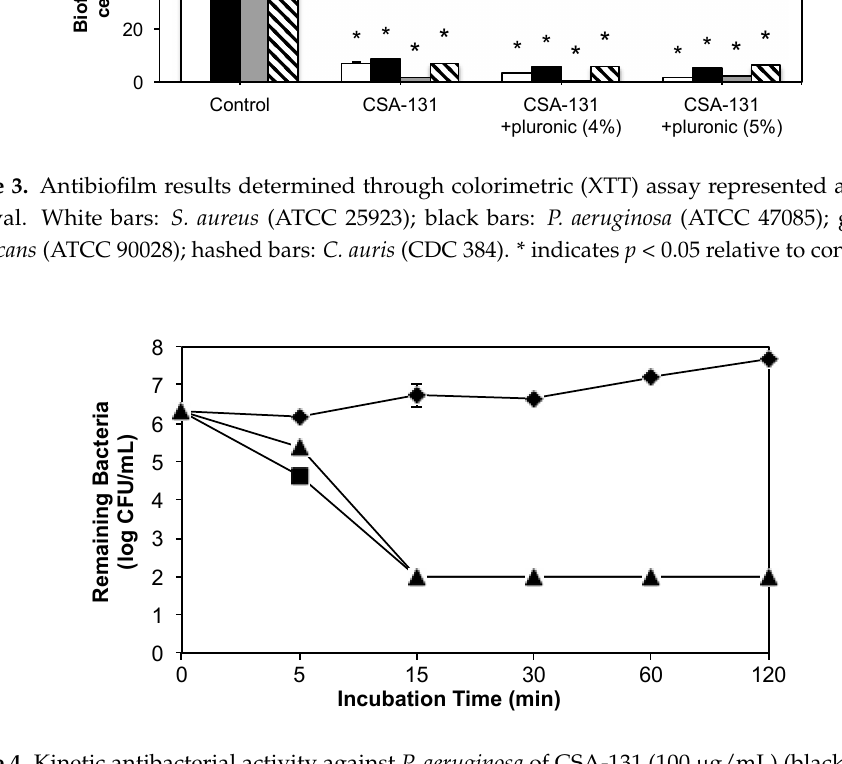
Sectioned into 2 x 1 cm explants Transferred to 24 well plate Figure 5. Description of methods used in harvesting and testing porcine trachea explants. With no treatment with CSA-131, all 12 explants cleared the applied beads within 20 min, and 10 of the explants cleared the beads in less than 10 min (Table 2). Treatment of the explants with CSA- 131 at 100 µg/mL for one hour caused a majority (six of 12) to lose the ability to clear the beads. Increasing amounts of pluronic (from 1 to 5%) restored the ability of the cilia to clear the beads, and at 5% pluronic, bead clearance was the same as the control.